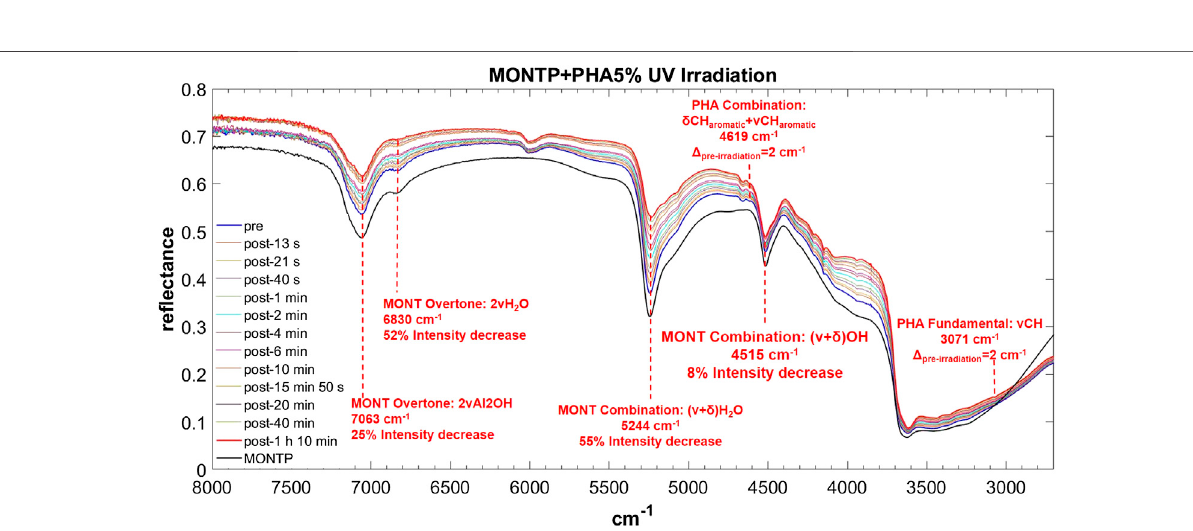
Frontiers in Astronomy and Space Sciences |